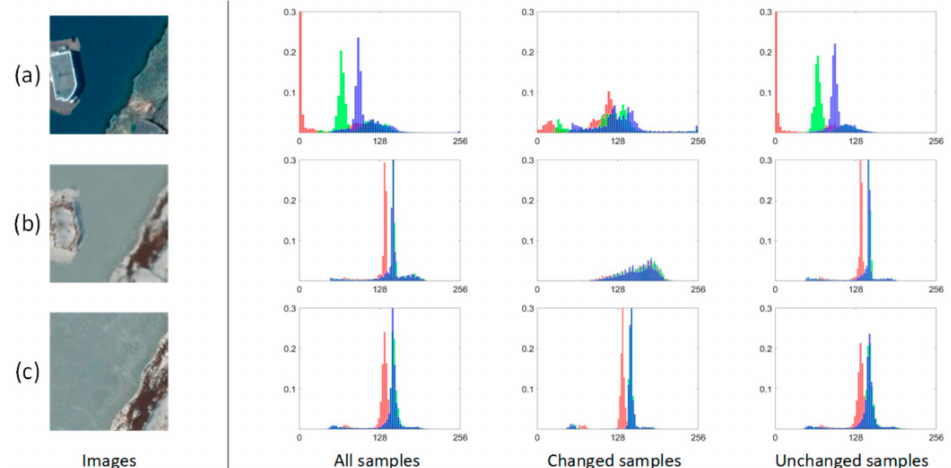
Figure 1. Illustration of our image transformation-based method for change detection using season-varying remote sensing images: ( a ) pre-event image, ( b ) translated image, ( c ) post-event